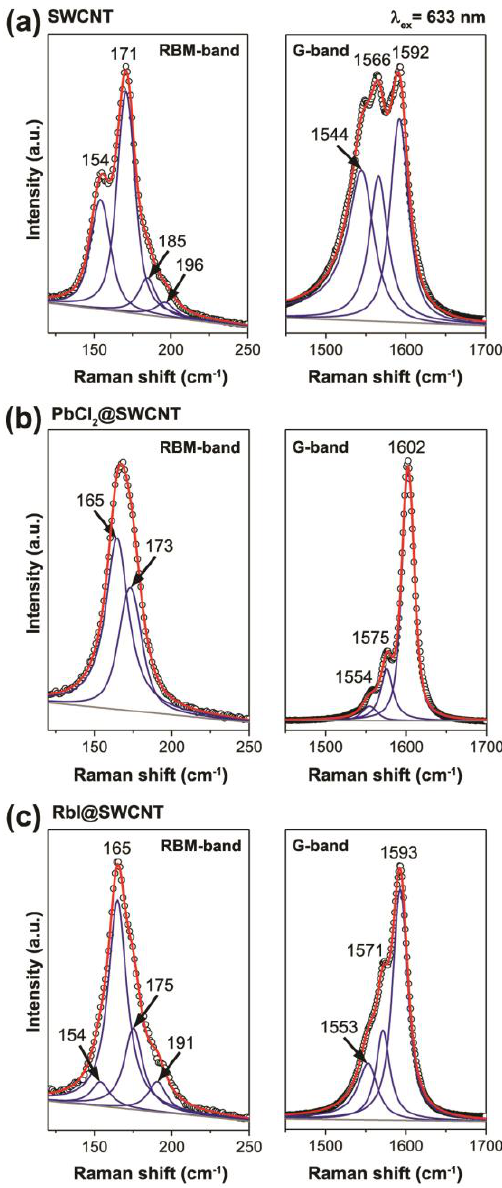
Figure 5. Raman spectra of pristine SWCNTs ( a ) (reproduced from M. V. Kharlamova et al. Revealing the doping effect of encapsulated lead halogenides on single‑walled carbon nanotubes, Appled Physics A, V. 125, article number 320, 2019, Springer Nature [145]) and the PbCl 2 -filled SWCNTs ( b ) (reproduced from M. V. Kharlamova et al. Revealing the doping effect of encapsulated lead halogenides on single-walled carbon nanotubes, Appled Physics A, V. 125, article number 320, 2019, Springer Nature [145]) and RbI ( c ) (reprinted with permission from [168], copyright 2019 Wiley-VCH Verlag GmbH & Co. KGaA, Weinheim) acquired at 1.96 eV-laser. The positions of the components are denoted.